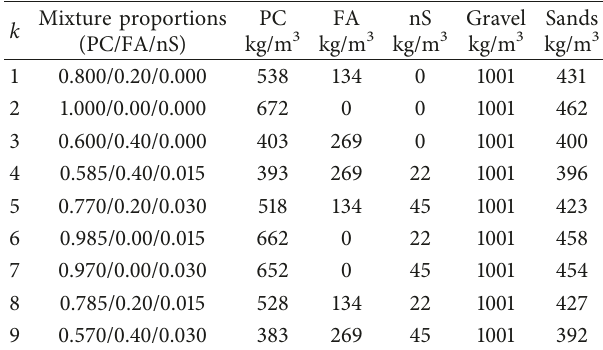
Table 2: Mixture proportion combinations evaluated of cement mixtures.